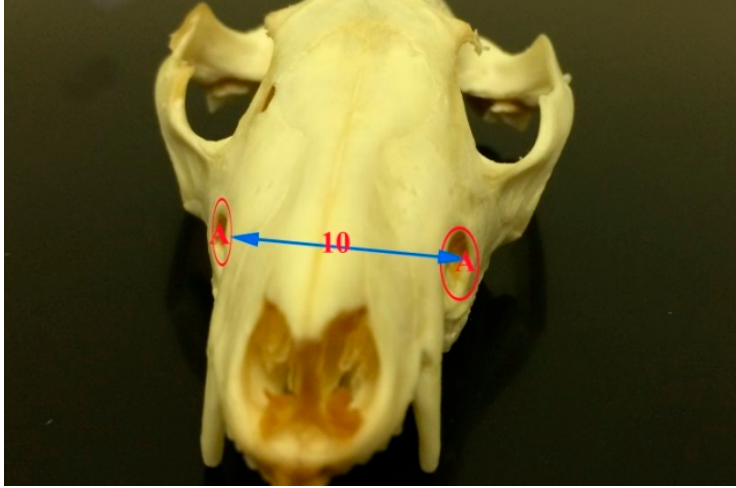
Figure 4. Photograph of frontal view of the skull of the common opossum showing the infraorbital foramina. A infraorbital foramen; and, 10 distance between the two infraorbital foramina.